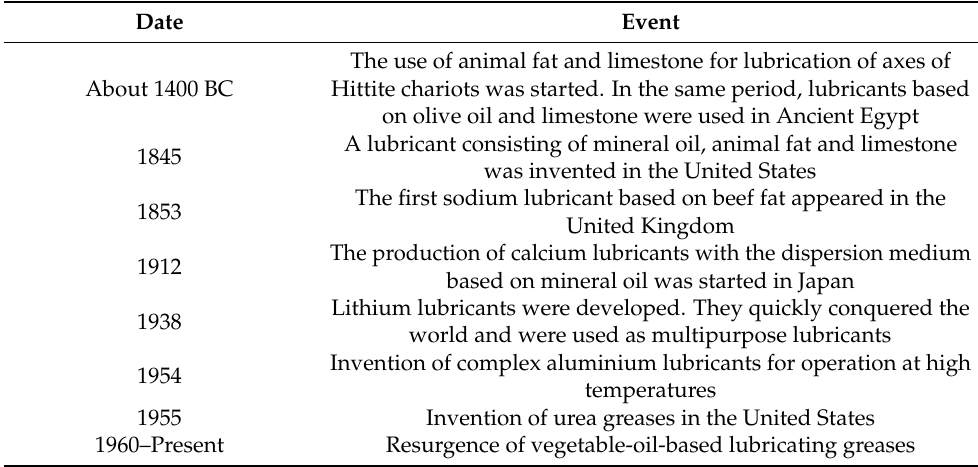
Table 11. Lubricating grease evolution through history